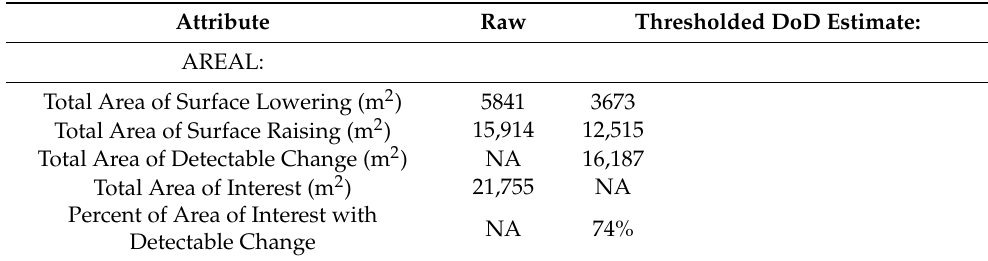
Table 2. Geomorphic changes in the Scott River alluvial fan flooded area (AoI FA ) during the August 2013 flood event, calculated using the DoD method in GCD software. Uncertainty was calculated using a minimum detection level (minLoD) of 0.02